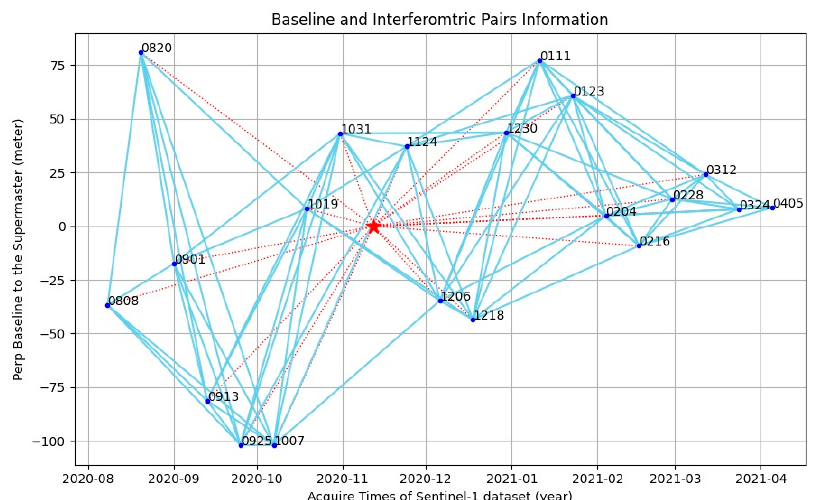
Figure 4. Temporal and spatial baselines of SAR datasets.